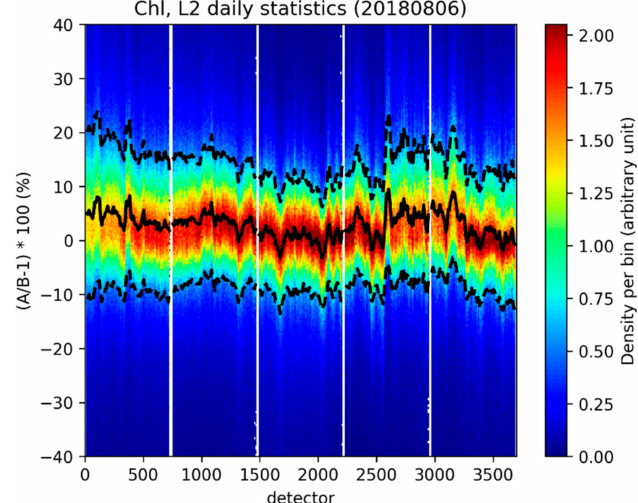
Figure 15. Relative di ff erences of harmonised OLCI-A and OLCI-B water-leaving reflectance (Oa03, 443 nm, left ; Oa06, 560 nm, right ) over one day statistics (20180806). Results are shown as histograms per bin of OLCI detector.